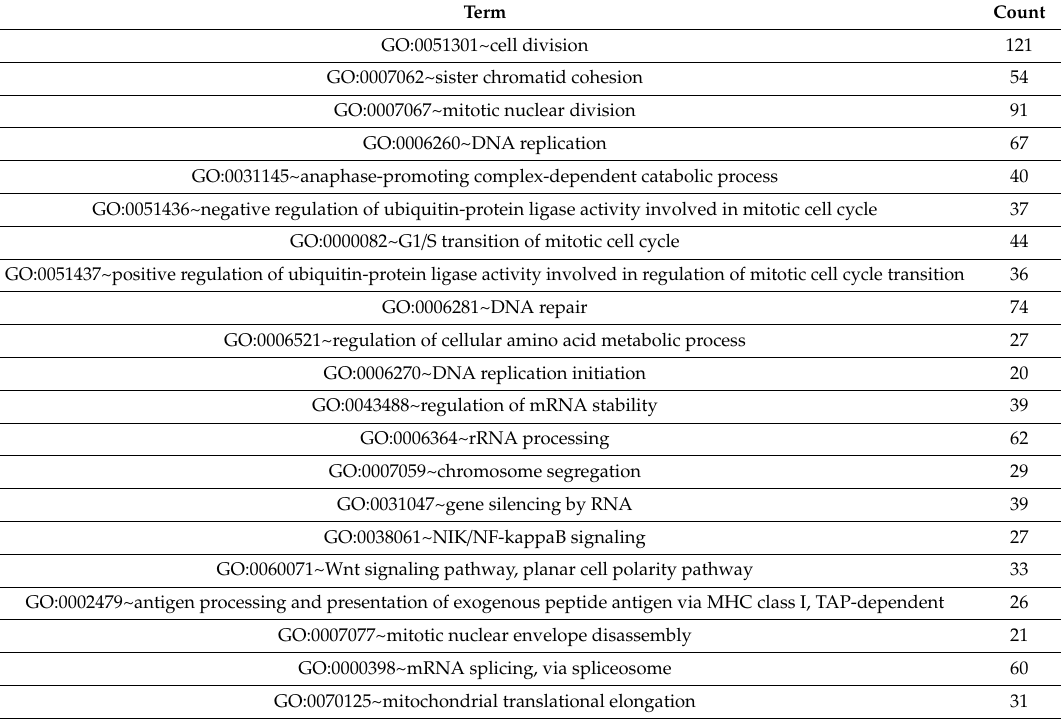
Table 8. Gene Ontology (GO) (Biological Process) of genes regulated in intestinal- and di ff use-type gastric cancer (GC). The total 2815 probe set IDs were analyzed for enrichment analysis in DAVID, which resulted in 2394 genes analyzed in GO Biological Process. Category of GOTERM_BP_DIRECT is